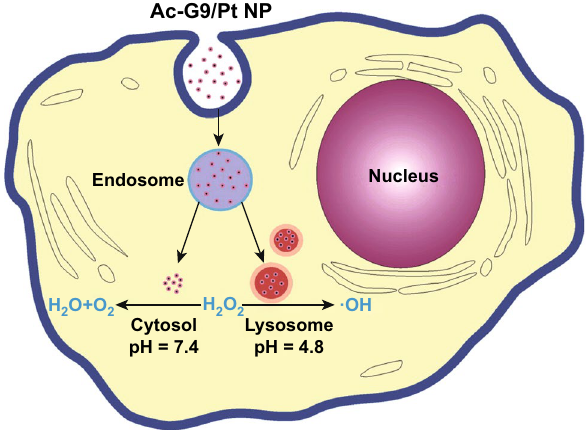
Fig. 9 pH dependence of the catalytic properties of gold nanozymes shows two decomposition routes for H 2 O 2 . Acidic media promote the splitting of H 2 O 2 into two hydroxyl radicals (peroxidase‑like activity), whereas neutral pH media decompose it into H 2 O and O 2 (catalase‑ like activity) [171]. Copyright 2013 American Chemical